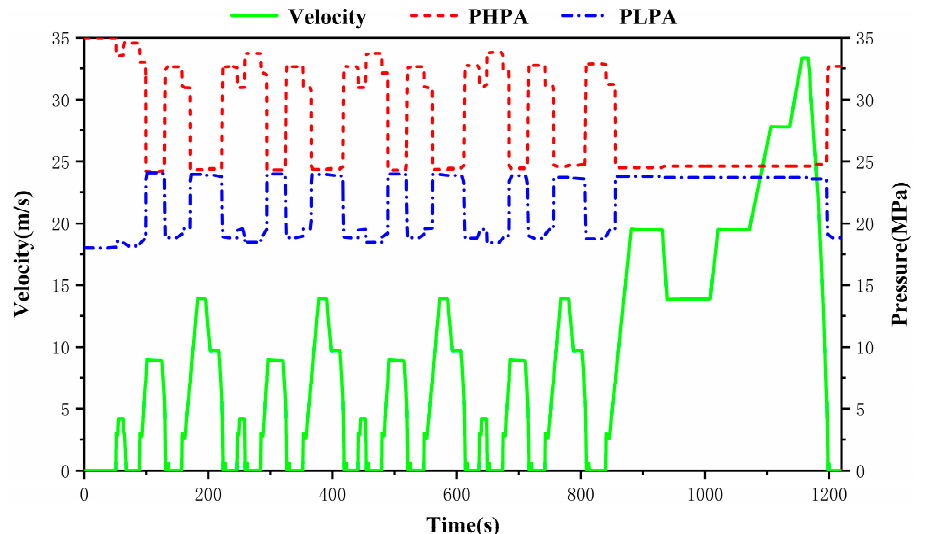
Figure 8. The curves for the PHPA and the PLPA.